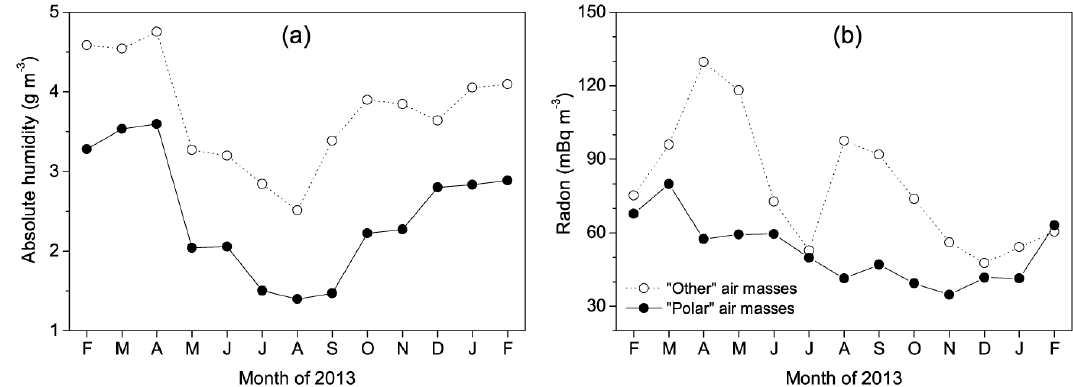
Figure 10. Comparison of monthly mean (a) absolute humidity and (b) radon concentration, between “polar” and other air masses.